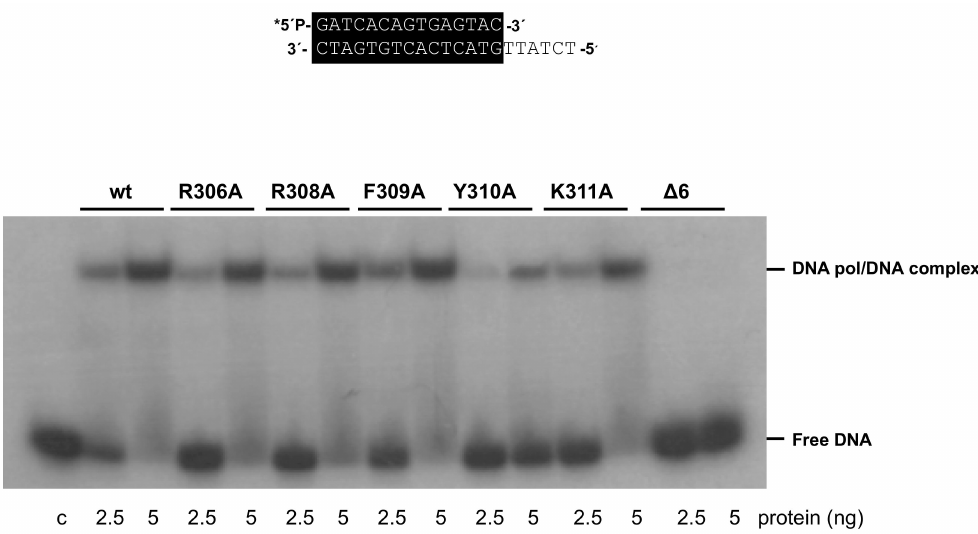
Figure 4. Gel retardation of dsDNA by wild-type and mutant Phi29 DNA polymerases. The assay was carried out as described in Materials and Methods, using the 5’-labeled primer / template molecule 15mer / 21mer depicted on top of the figure, in the presence of the indicated amounts of enzyme. After non-denaturing gel electrophoresis, the bands corresponding to free dsDNA and to the DNA polymerase-DNA complex were detected by autoradiography. Asterisk indicates the 5’- 32 P-labeled end of the primer strand; c: control